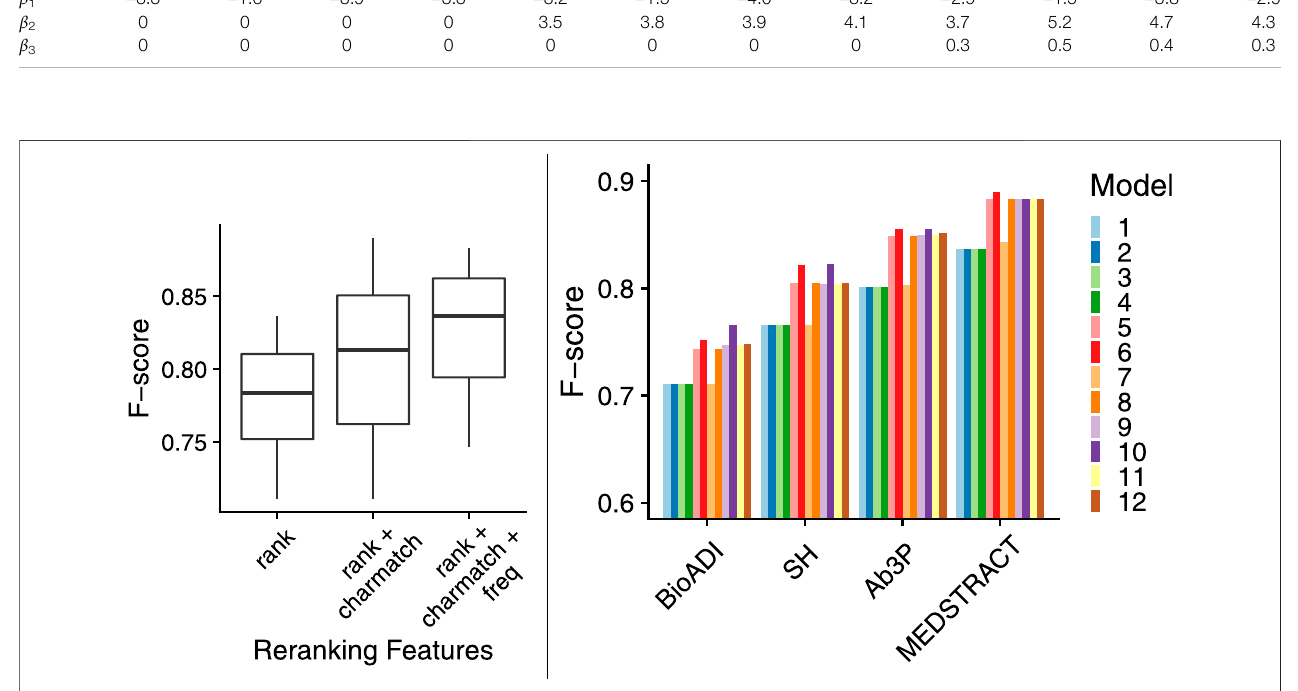
FIGURE 7 | More features → better F-scores; boxplots (left panel) summarize 48 bars (right panel).